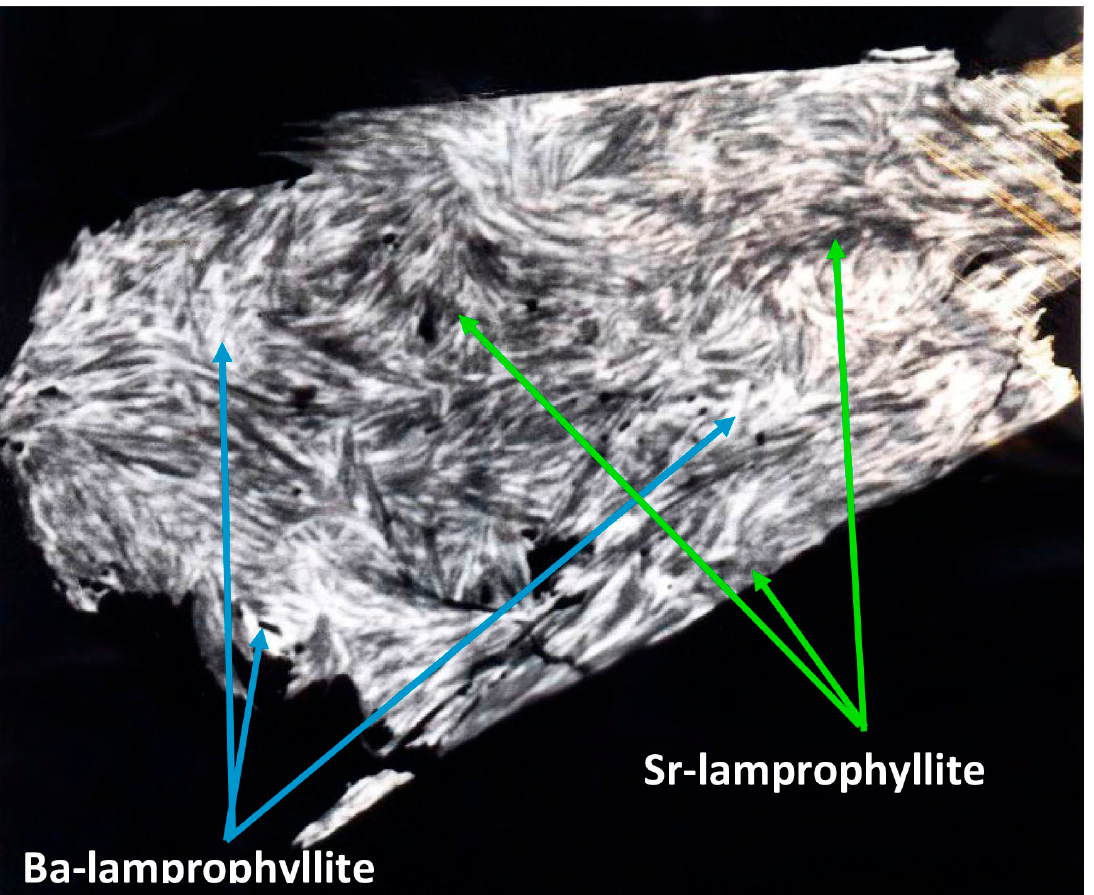
Figure 6. Mush of lamprophyllite (field of view 0.25 mm). The mush is represented by a mixture of barium and strontium lamprophyllite. Light crystals—Ba-lamprophyllite; dark crystals—Sr-lamprophyllite.